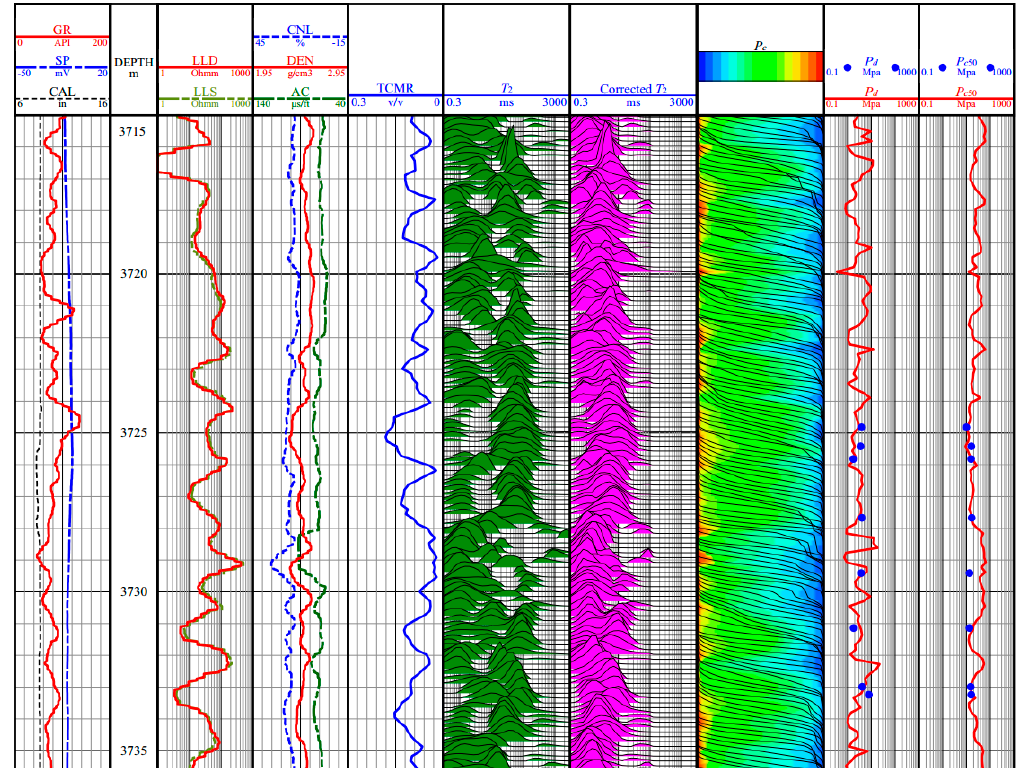
Figure 9. Pore structure prediction results for lower sweet spot reservoir in Well Ji32.